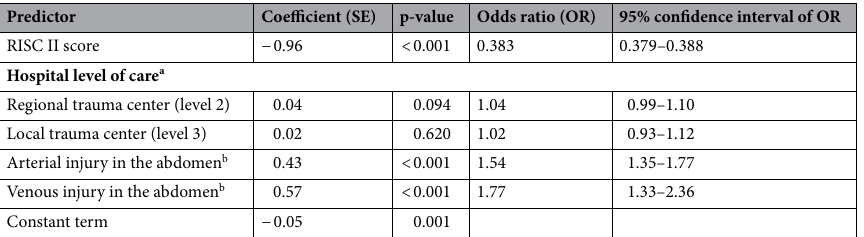
Table 5. Results of logistic regression analysis with in-hospital mortality as dependent variable. The analysis is based on 164,370 patients; Nagelkerke’s R 2 = 0.585. a Reference group: supra regional trauma center (level 1). b Reference group: no such injury